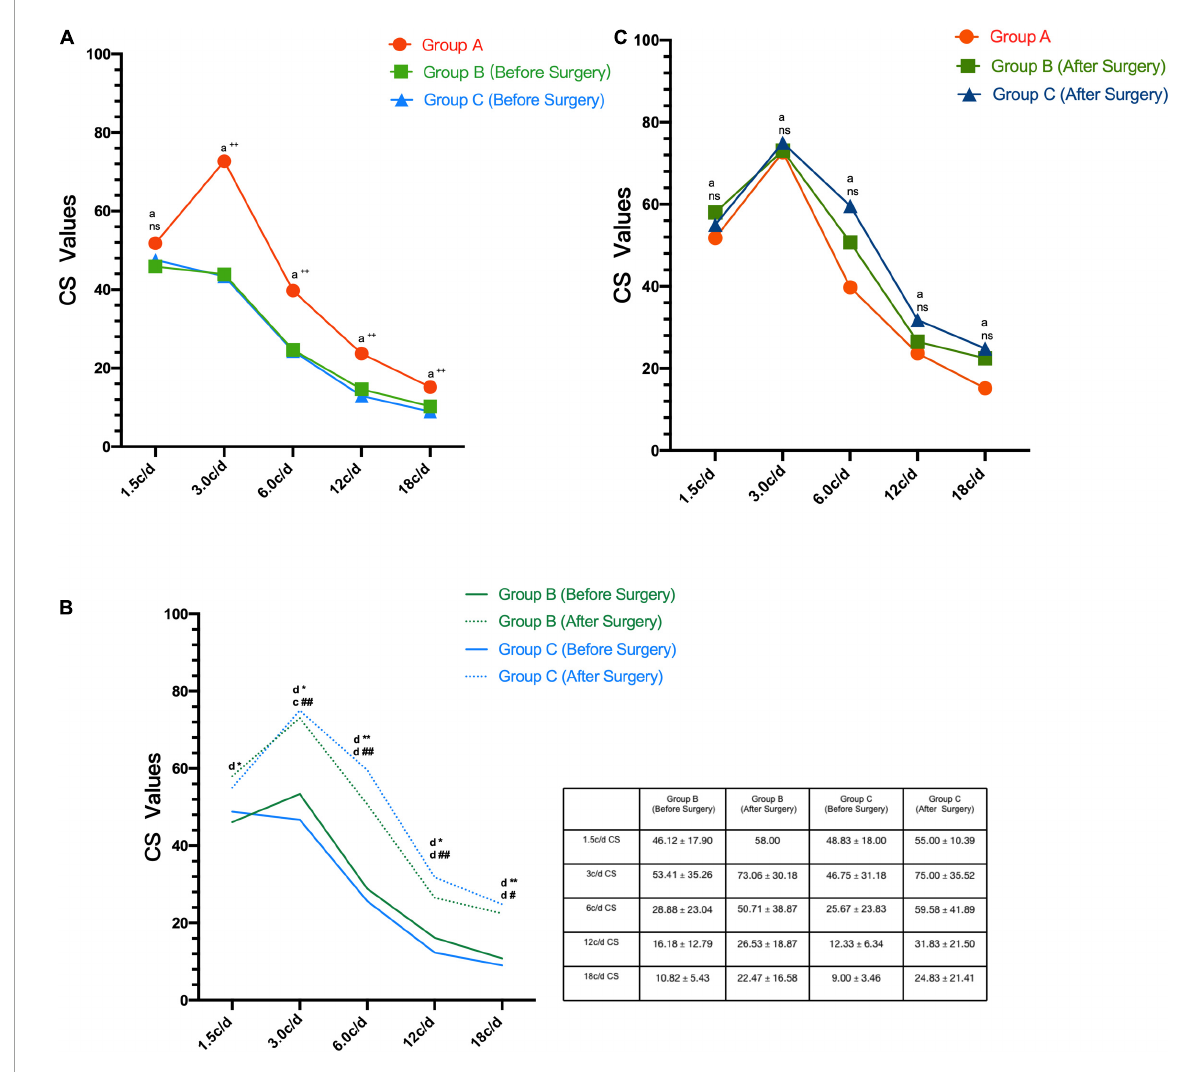
FIGURE2 (A) CS values at each spatial frequency (1.5, 3.0, 6.0, 12, 18 c/d) in Group A, Group B (Before Surgery), and Group C (Before Surgery) (B) . Preoperative and postoperative CS values at each spatial frequency (1.5, 3.0, 6.0, 12, 18 c/d) in Group B and Group C (C) . CS values at each spatial frequency (1.5, 3.0, 6.0, 12, 18 c/d) in Group A, Group B (After Surgery), and Group C (After Surgery). (CS, contrast sensitivity; c/d, cycle per degree; a Kruskal-Wallis test; c Paired t -test; d Wilcoxon test; ns P > 0.05: compare among the three groups; ++ P < 0.01: compare between Group A and Group B; ** P < 0.01:compare before and after surgery in the Group B; * P < 0.05:compare before and after surgery in the Group B; ## P < 0.01:compare before and after surgery in the Group C; # P < 0.05: compare before and after surgery in the Group